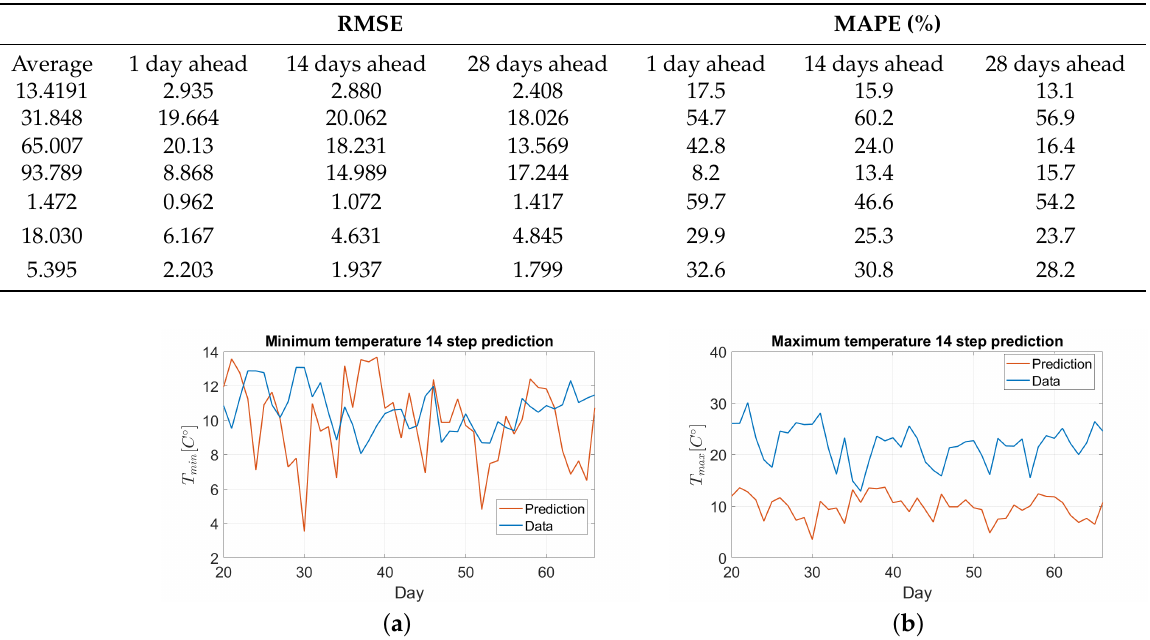
Table 4. Results for the summer data.